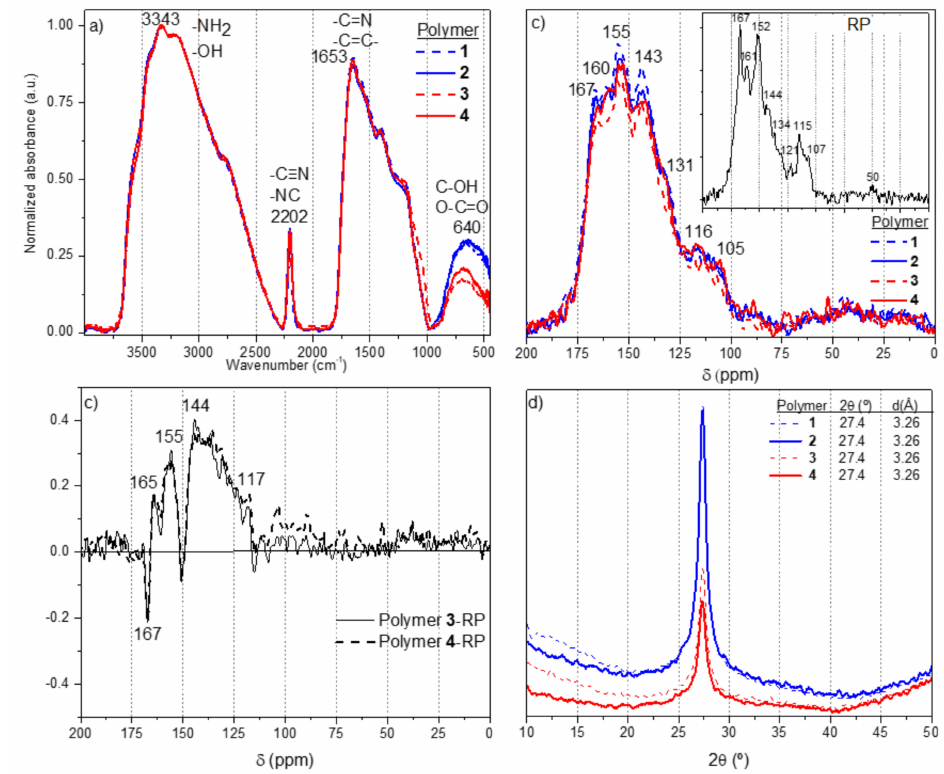
Figure 1. ( a ) Representative FTIR spectra of polymers 1 – 4 . ( b ) Solid state 13 C NMR spectra of polymers 1 – 4 . In the insert plot, the 13 C NMR spectrum of the RP is shown [8]; ( c ) Subtractions of the 13 C NMR spectra; ( d ) Representative XRD patters of polymers 1 – 4